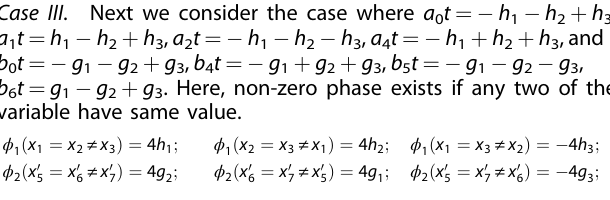
Fig. 2d, e and f respectively. Circuits for e (cid:2) iH 1 x 2 t are similar. Circuit for e (cid:2) iH 1 x t in each case is obtained by concatenating the corresponding